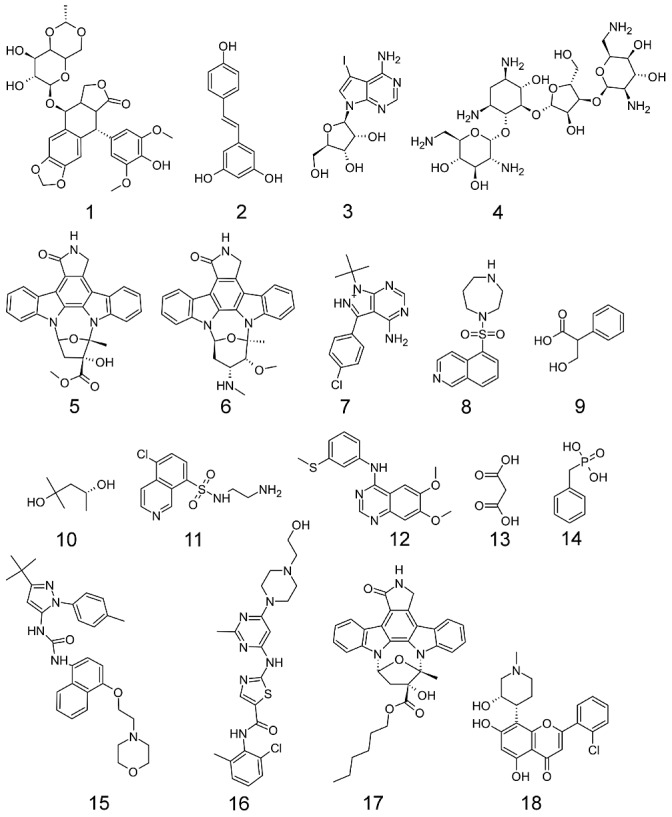
Structures of compounds that elicited a phenotype in C. elegans.

1 (DB00773) Etoposide, 2 (DB02709) Resveratrol, 3 (DB04604) 5-iodotubercidin, 4 (DB03615s) Neomycin, 5 (DB02152) K-252a, 6 (DB02010) staurosporine, 7 (DB03023) PP2, 8 (DB04707) HA1077, 9 (DB04080s) Tropic Acid, 10 (DB03684) 2-methyl pentanediol, 11 (DB03693) N-(2-Aminoethyl)-5-Chloroisoquinoline-8-Sulfonamide, 12 (DB02984) 4-[3-Methylsulfanylanilino]-6,7-Dimethoxyquinazoline, 13 (DB02175) malonic acid, 14 (DB02908s) Benzylphosphonic Acid, 15 (DB03044) BIRB 796, 16 (DB01254) Dasatinib, 17 (DB01933) KT-5720, 18 (DB03496) Flavopiridol.